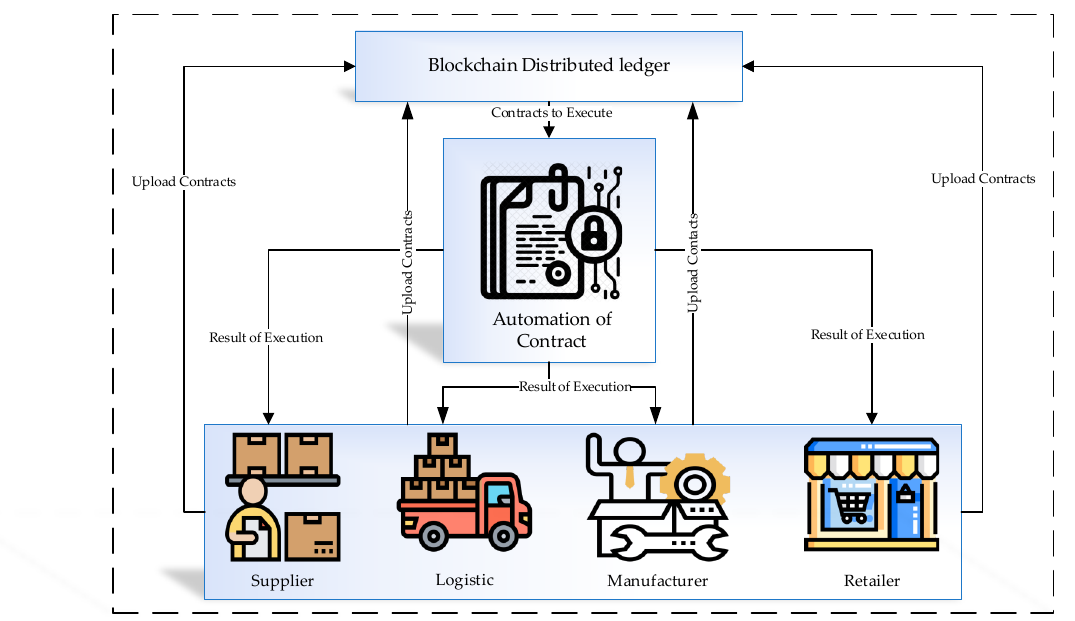
Figure 5. Distributed ledger contract automation based on